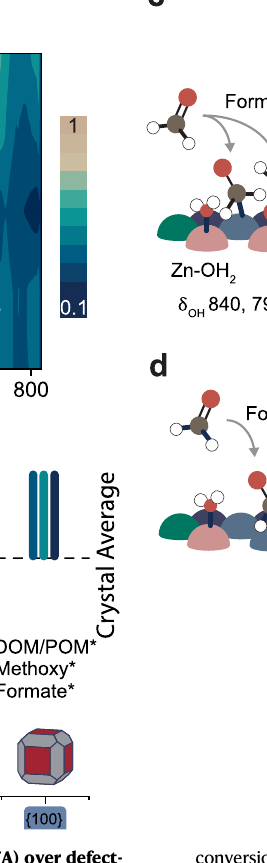
conversion, as intermediatesare observed atlowerpressures on high-indexplanes (note:pyrrole-induced changes incrystalfacetsize ratiospreventedthe analysisof the {111} facets). Based on the observed species and in accordance with the literature 32,48 , we propose two possible mechanisms for FA conversion over defective ZIF-8: a methoxy-mediated ( c ) and formate-mediated ( d )